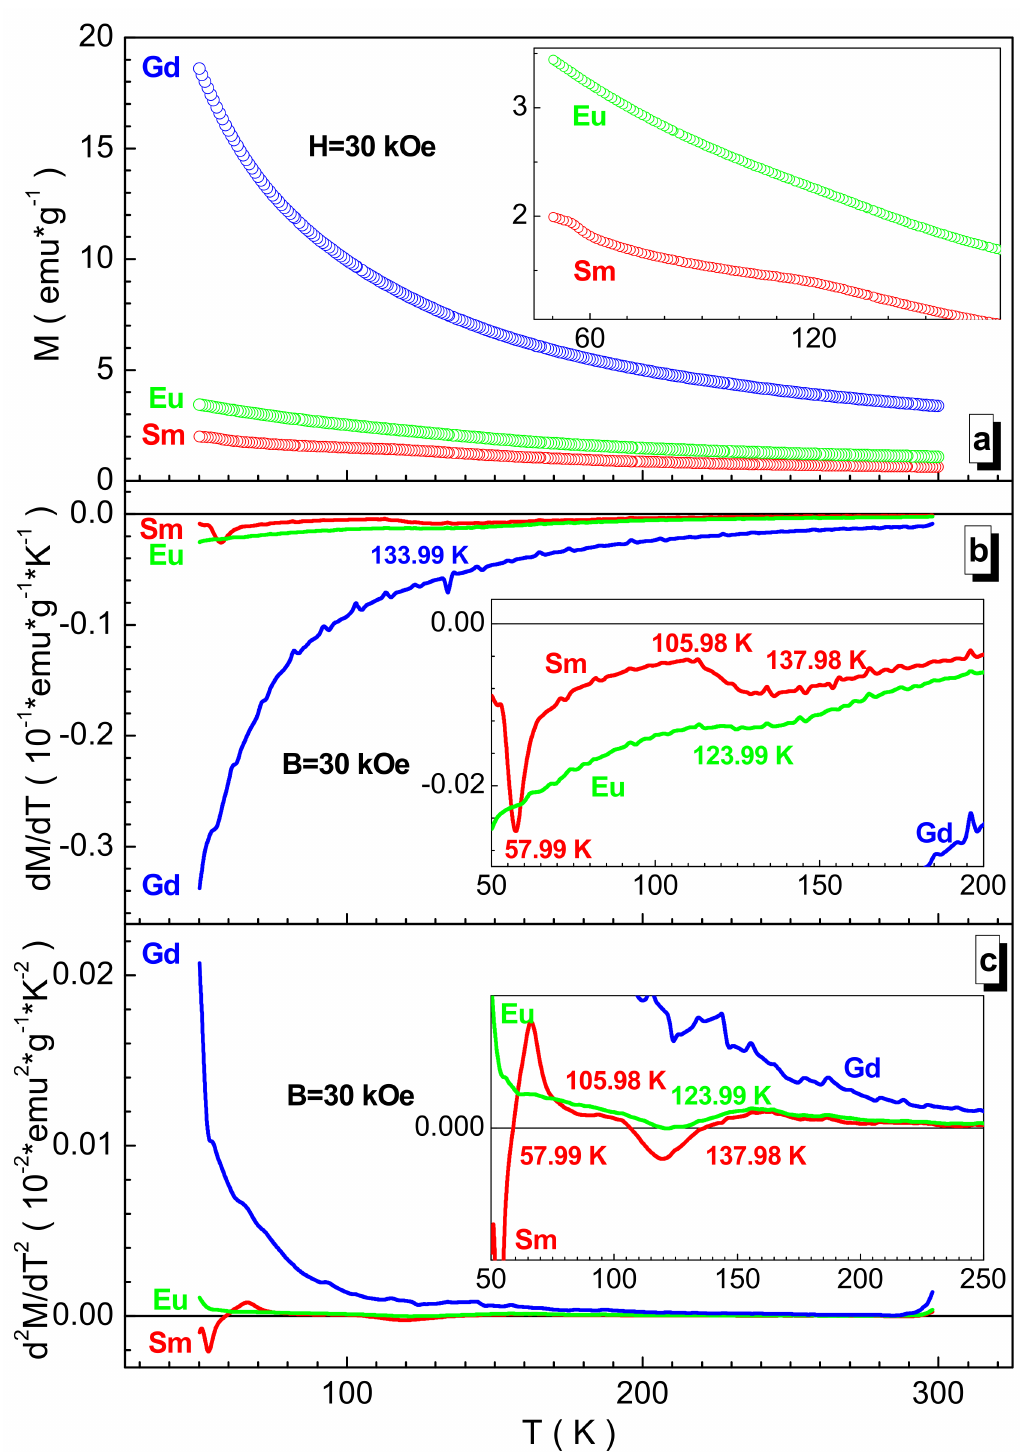
Figure 7. M(T) temperature magnetization ( a ), dM/dT(T) first magnetization derivative ( b ), and d 2 M/dT 2 (T) second magnetization derivative for the Sm- (red circle), Eu- (green circle) ( c ), and Gd- based (blue circle) samples in 3 T. Inset demonstrates the temperature magnetization on a larger